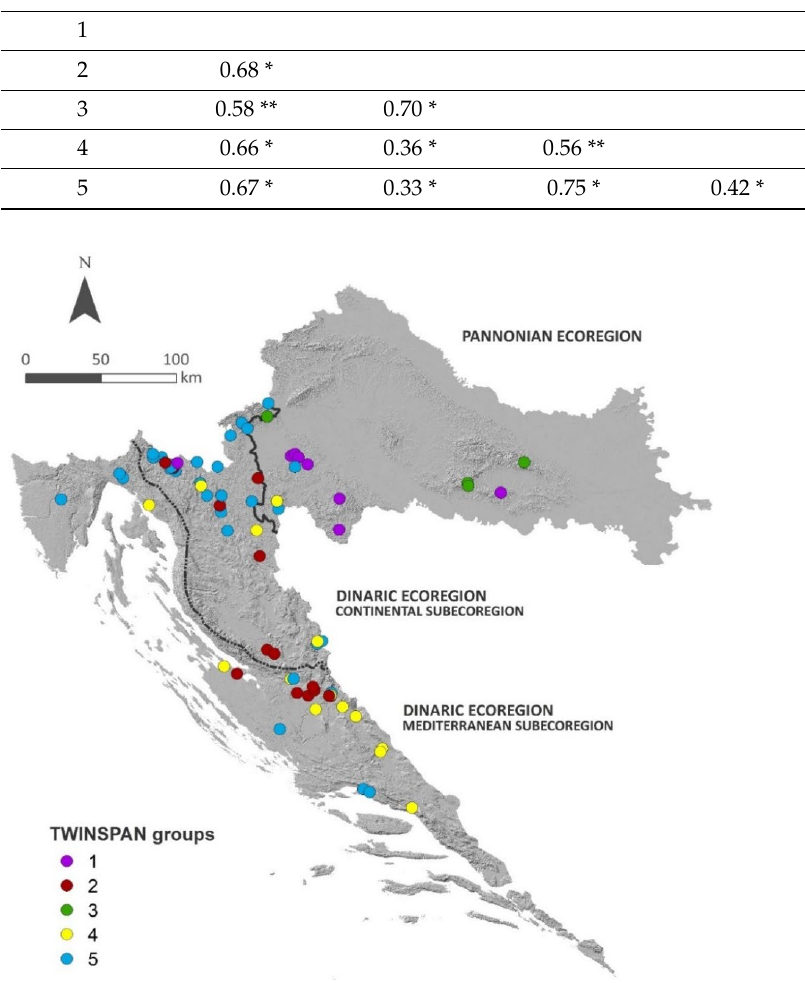
Figure 1. Distribution map of TWINSPAN groups in Croatia and its hydrological and biogeographical sub- and ecoregions. Table 2. Distribution of the TWINSPAN groups over the hydrological and biogeographical sub- and